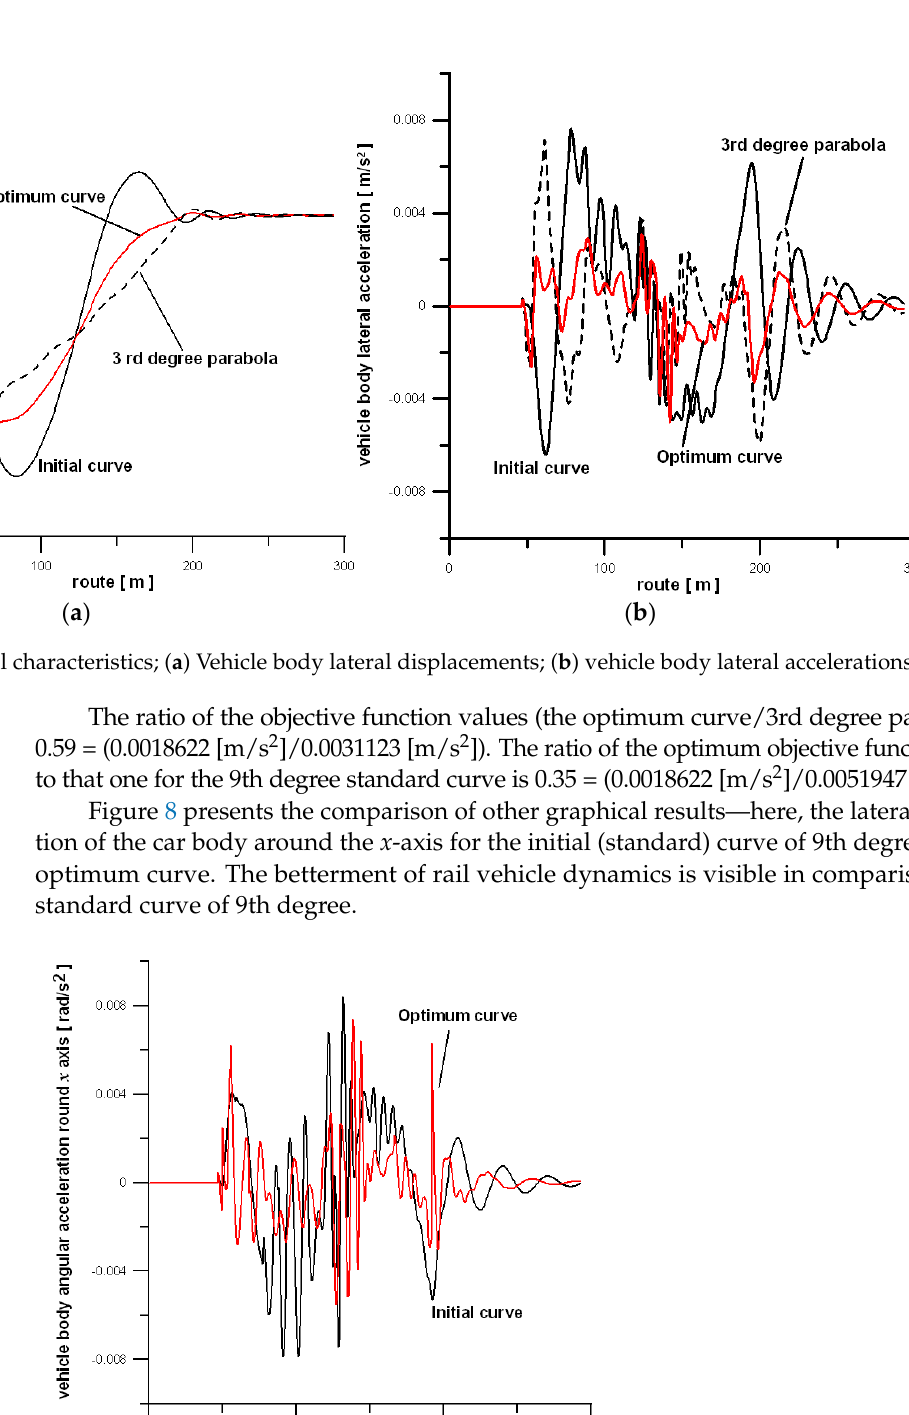
( b ) Figure 6. Transitions curves: ( a ) Curve offsets; ( b ) curvatures.